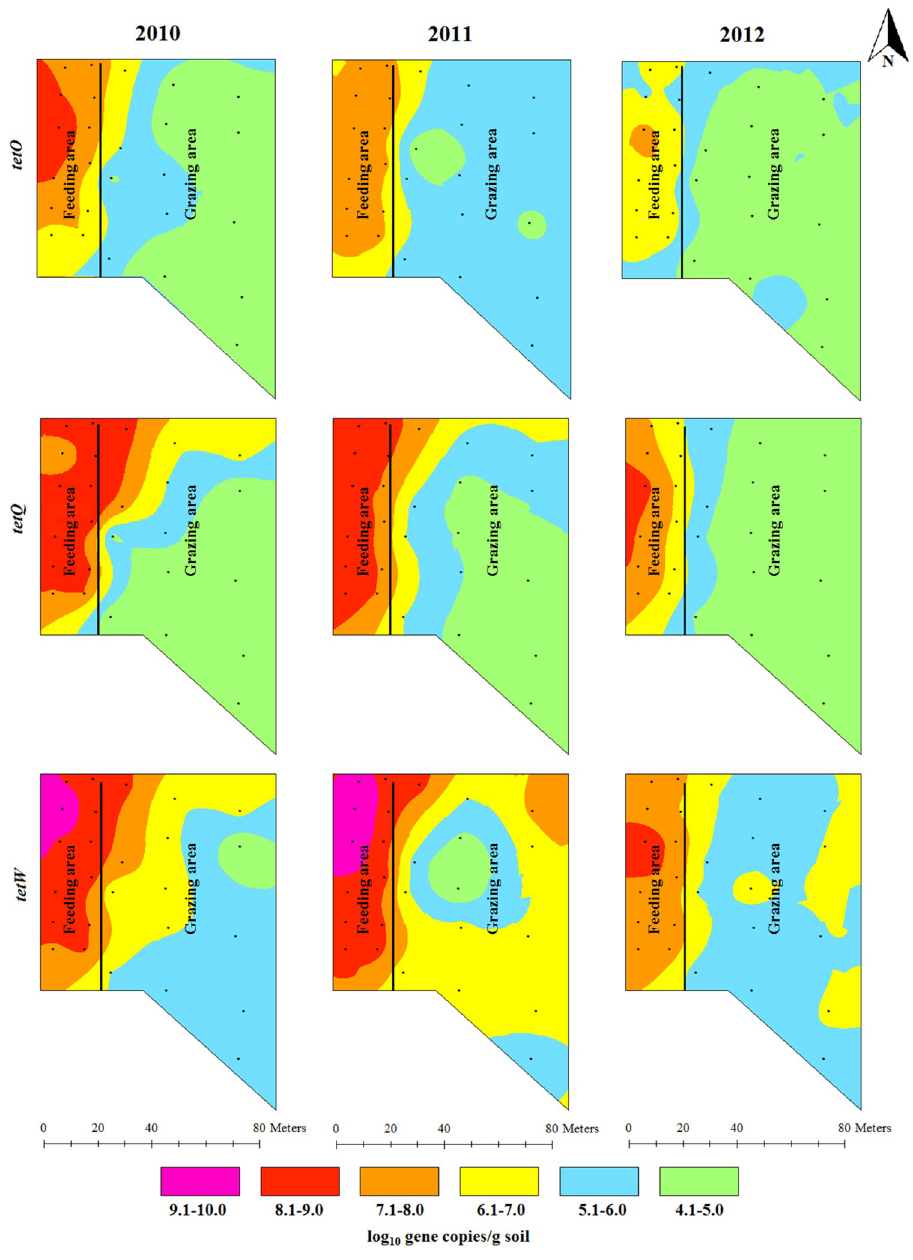
Fig 5. Spatial distributions of three tetracycline resistance genes ( tet O, tet W and tet Q) concentrations in beef cattle backgrounding environment over a two years period after cattle removal.